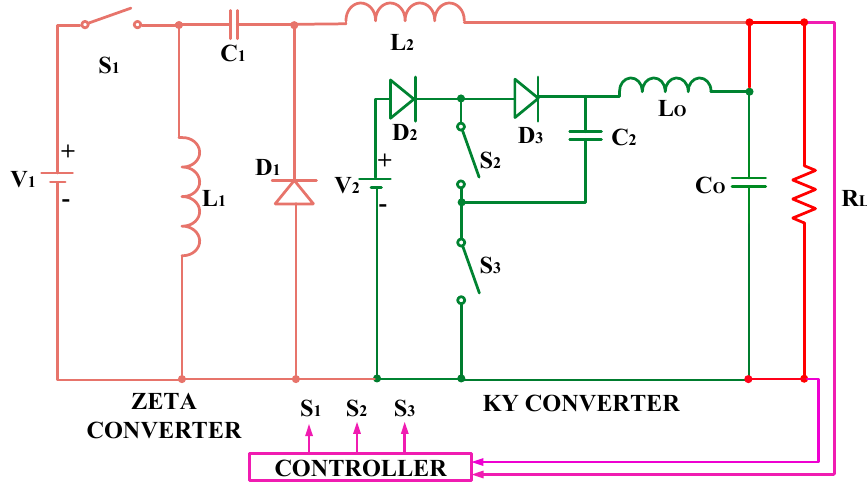
Figure 3. Modified three port Zeta-KY dc-dc unidirectional converter.